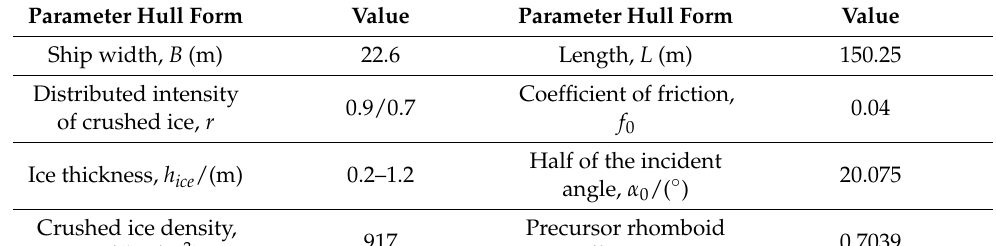
Table 13. DuBrovin calculation parameters selected for this ship model (Semi bow).